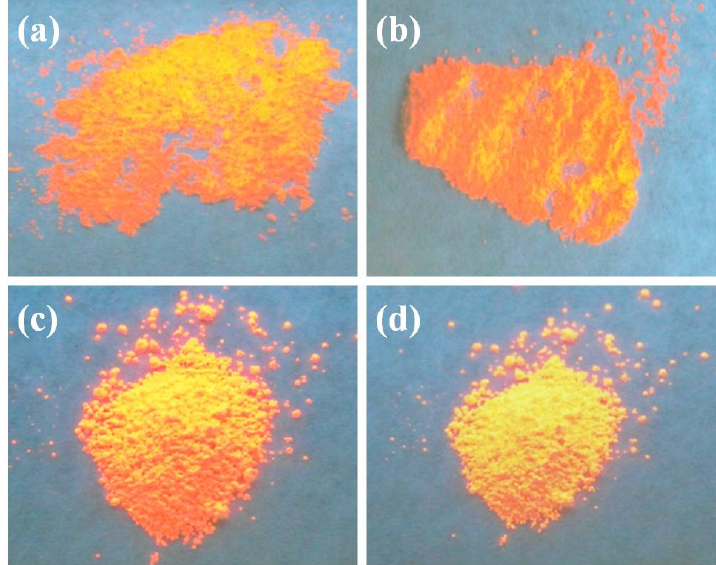
Figure 6. Photographs for the light emissions of heated Eu-BZO phosphors. ( a ) One-step Eu-BZO powder heated at 1300 °C and two-step Eu-BZO powders heated at ( b ) 1100 °C, ( c ) 1200 °C, and ( d ) 1400 °C, respectively.